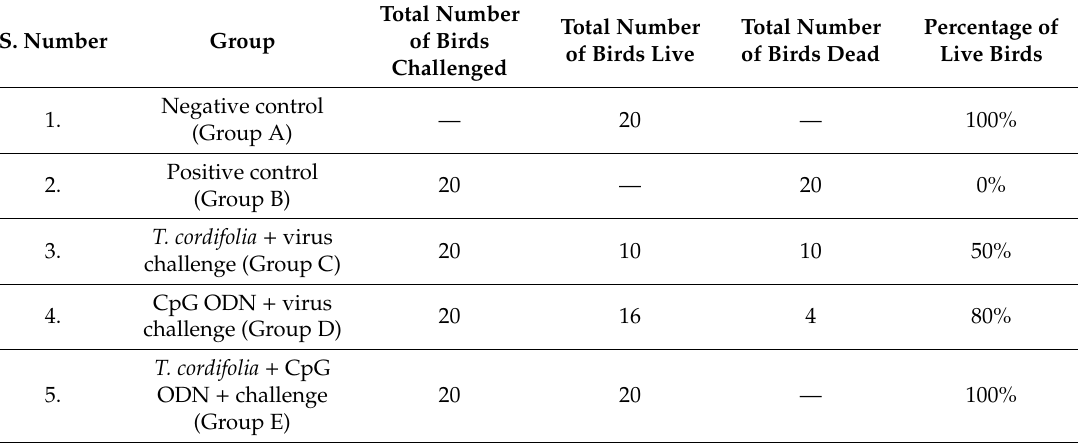
Table 12. Protection observed in di ff erent vvIBDV challenge